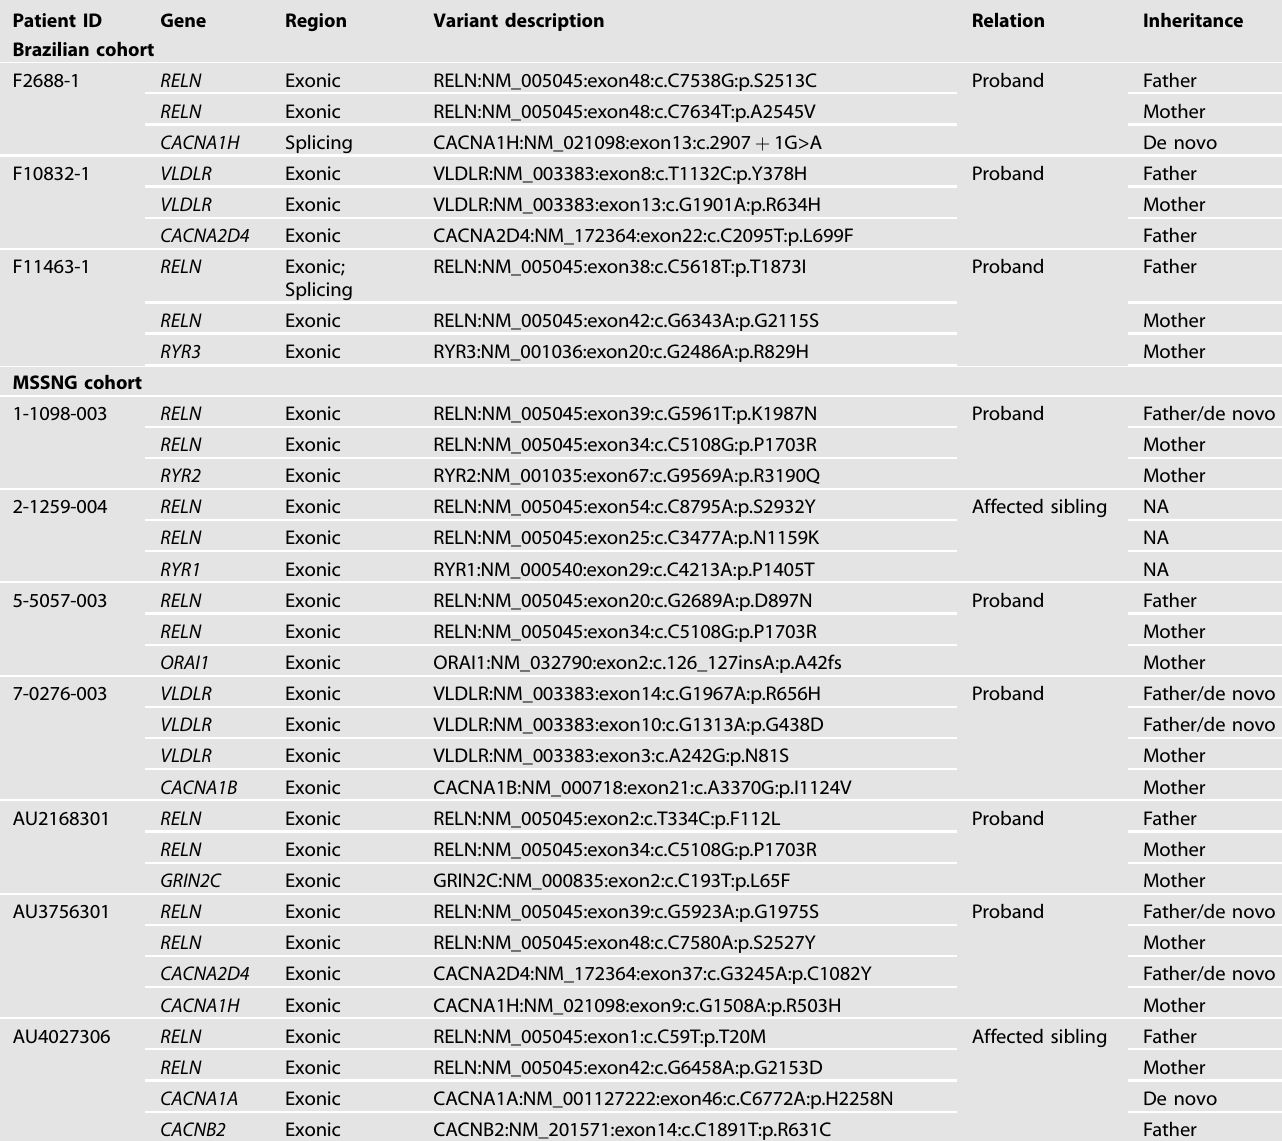
Table 1. Rare variants identi fi ed in both alleles of either RELN or VLDLR genes and in one allele of genes for Ca 2 + channels in individuals with